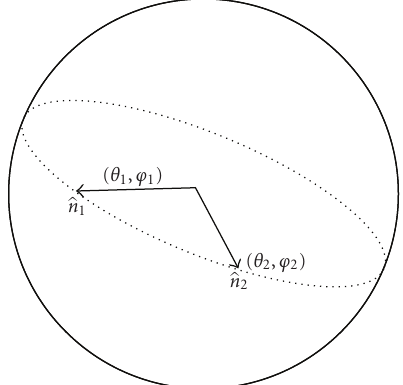
Figure 3: Geometrical representation of the 2pcf in terms of two unit